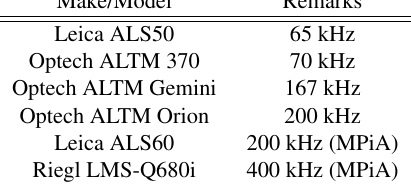
Table 2: Airborne LiDAR equipments in Taiwan